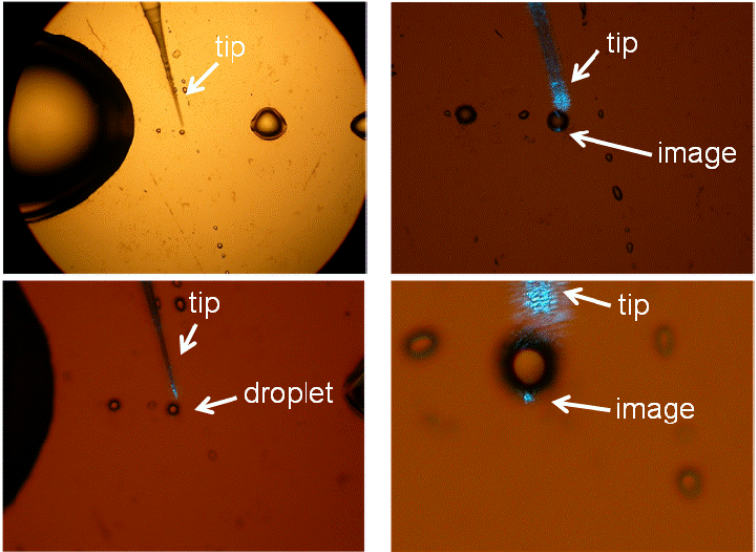
Figure 10. Experimental testing of the imaging mechanism of the glycerin microdroplets shown at different magnifications. The droplet is illuminated near the edge with a tapered fiber tip of a near-field scanning optical microscope (NSOM). Image of the NSOM tip is clearly seen at the opposite edge of the